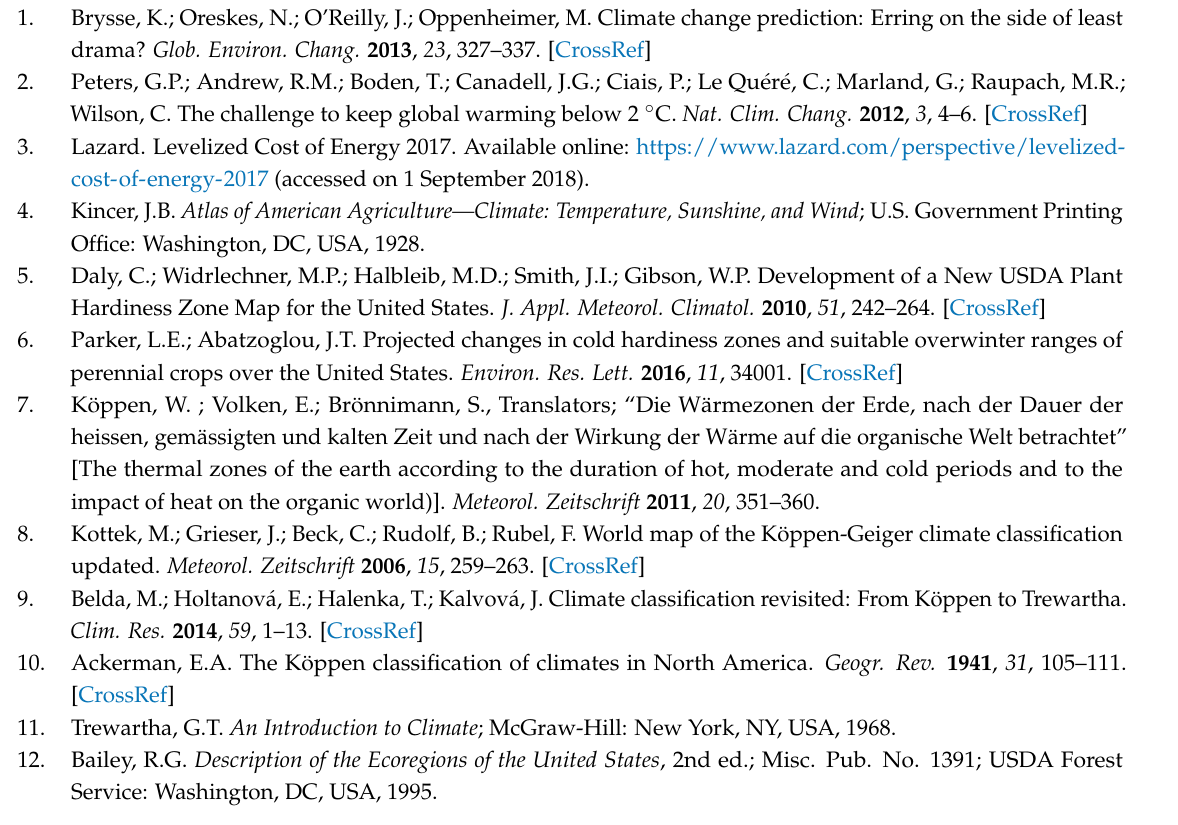
Table S1: Percent of total area for plant hardiness zones under current climate and GFDL-ESM2G RCP8.5, CanESM2 RCP8.5, and HadGEM2-ES RCP8.5 in the United States, Table S2: Percent of total area for Köppen-Trewartha climate types under current climate and GFDL-ESM2G RCP8.5, CanESM2 RCP8.5, and HadGEM2-ES RCP8.5 in the United